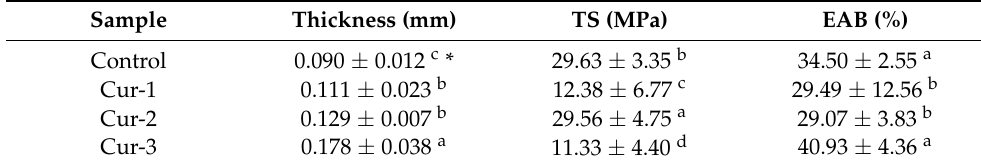
Table 3. Mechanical properties of the films obtained at 25 ◦ C and 25%